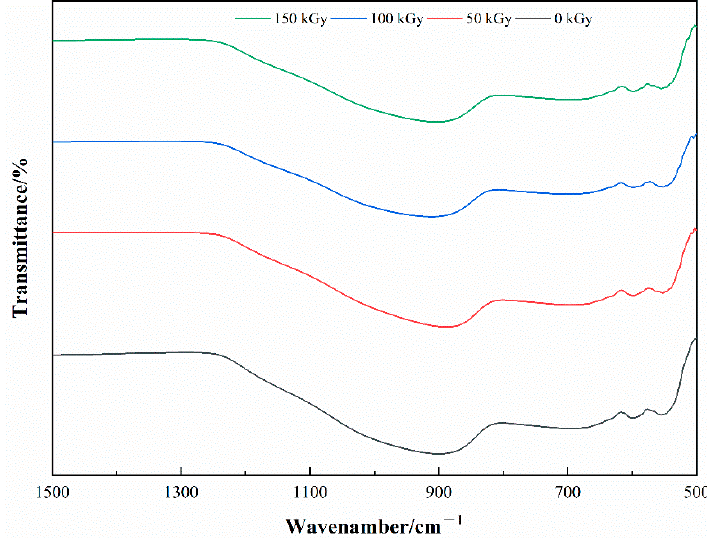
Figure 7. Fiber ‐ 2 FTIR Characteristics before and after the irradiation.